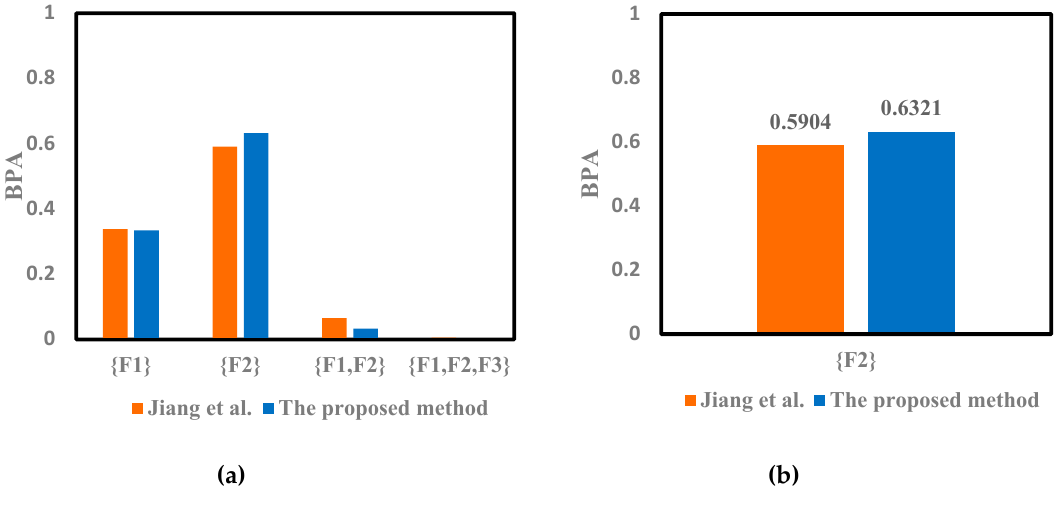
Figure 4. The comparison of di ff erent methods for motor rotor fault diagnosis at 3 X frequency. ( a ) Fusion results of di ff erent methods. ( b ) The result of { F 2 } for 3 X .